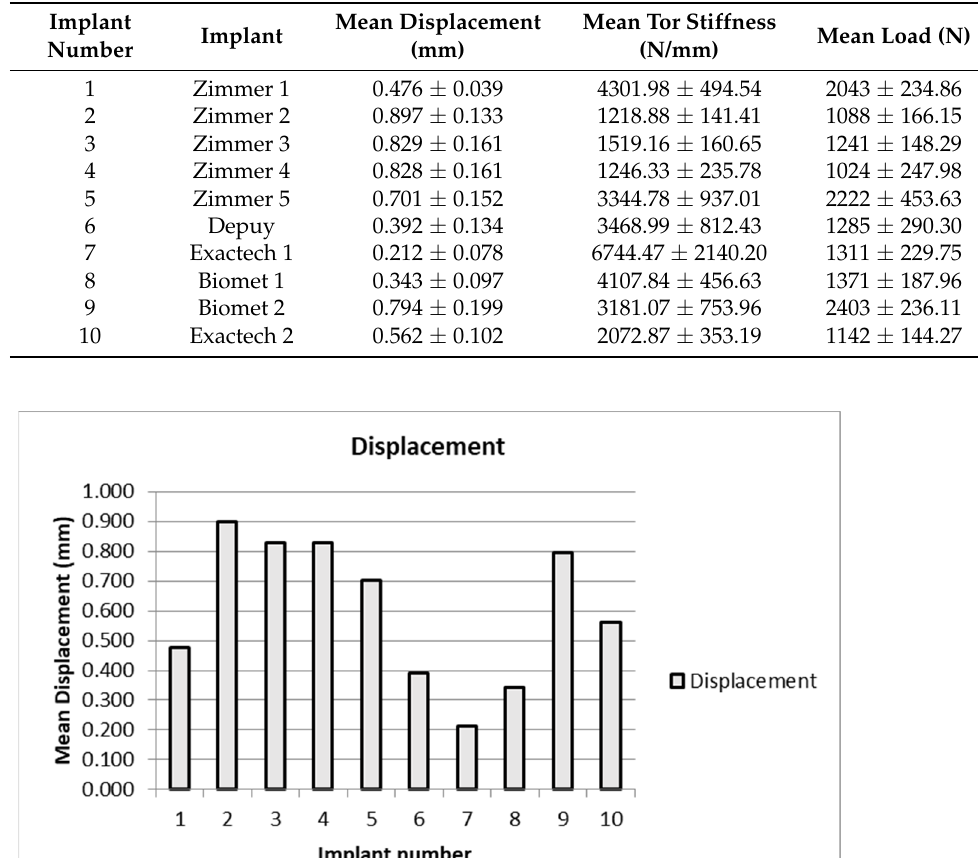
Figure 3. Mean displacement of each implant.